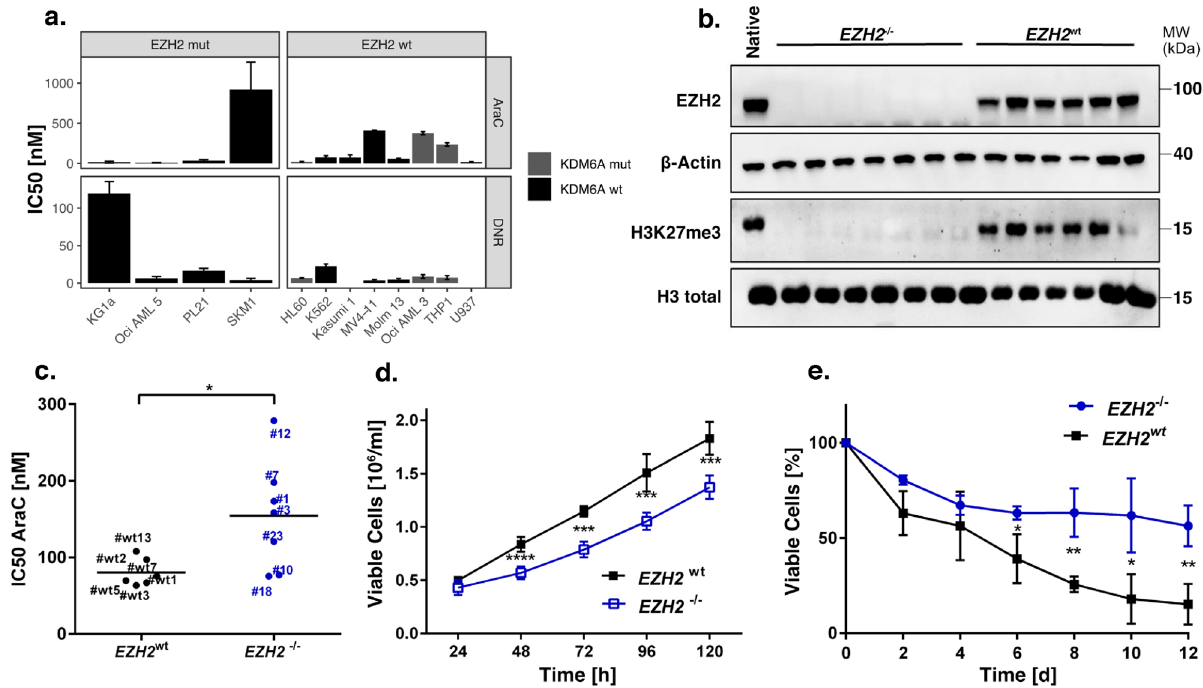
Figure 4. EZH2 depletion promotes resistance in the myeloid cell line K562. (a) Comparison of IC 50 values for DNR and AraC in twelve haematopoietic cell lines. Cells were treated with AraC/DNR for 72 h. (b) Immunoblot for EZH2 expression and global H3K27me3 of seven EZH2 −/− and six EZH2 wt sc clones in K562 cells. MW, molecular weight; β-actin and H3 total, loading controls. (c) Comparison of AraC IC 50 values in EZH2 wt (n = 6) and EZH2 −/− (n = 7) clones. Cells were treated with AraC/DMSO for 72 h. Each value represents the mean of three independent experiments. (d) Proliferation of EZH2 wt (n = 4) and EZH2 −/− (n = 7) clones for 5 d. Medium was changed every 48 h. (e), Long-term low dose AraC treatment in EZH2 wt (n = 3) and EZH2 −/− (n = 3) clones. Cells were treated with 30 nM AraC/DMSO for 12 d. Viable cells relative to untreated control. Unpaired, two- tailed Student’s t-test; * p < 0.05; ** p < 0.01; *** p < 0.001. Error bars indicate mean ± s.d of three independent